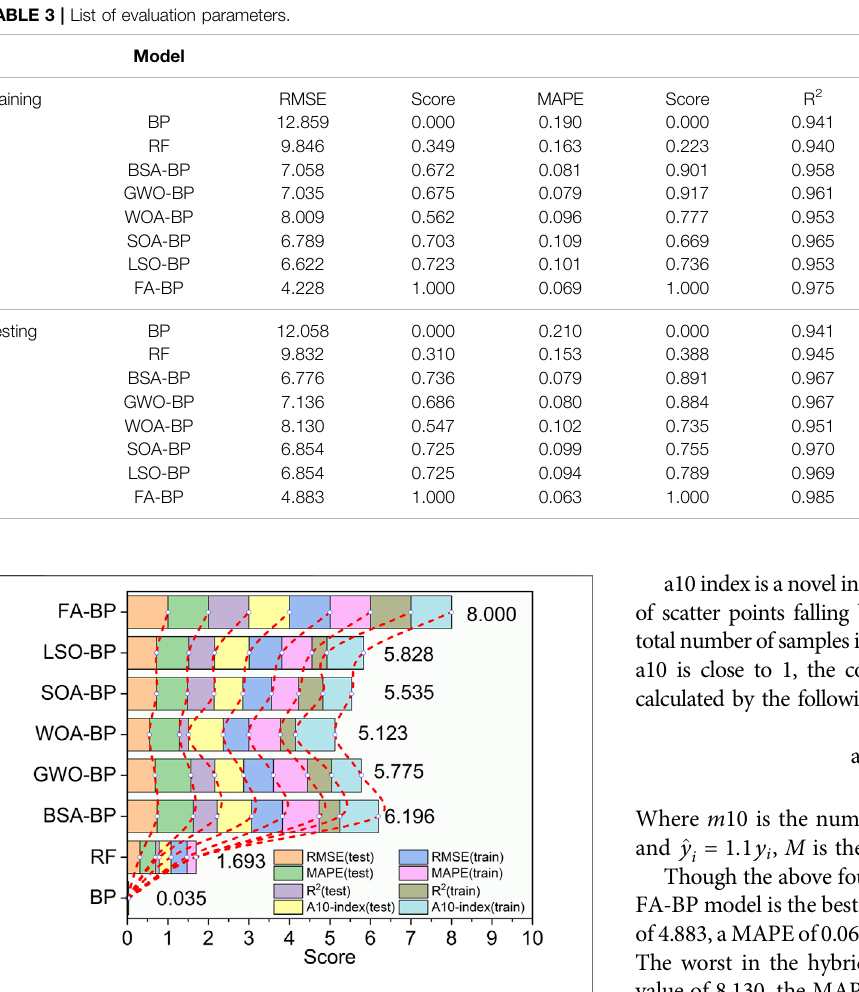
TABLE 3 | List of evaluation parameters.